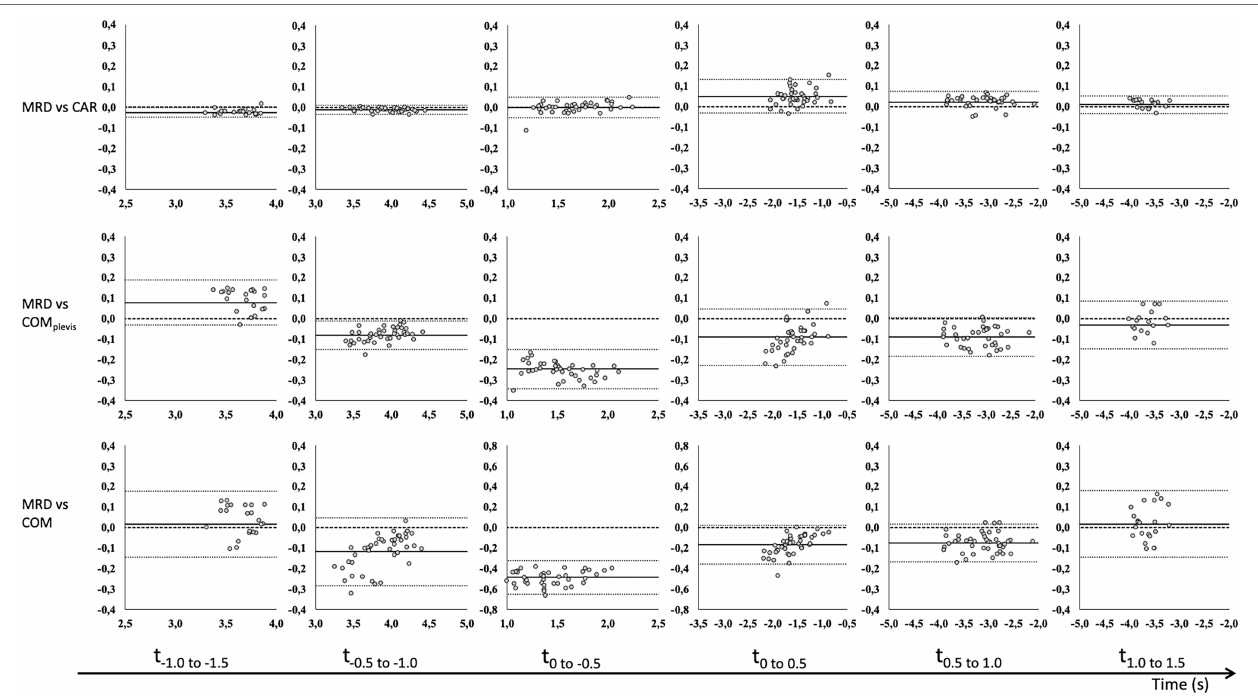
FIGURE 4 | Bland–Altman analysis of average velocity for 0.5 s time intervals before ( − ) and after (+) CoD (horizontal axis) for the MRD to CAR (top row), COM pelvis (middle row) and COM (bottom row) for 9 kg external load. Bland–Altman plots [y-axis: difference in velocity (m/s) and x-axis: average velocity (m/s)] for all trials with fixed bias (full line) with 95% confidence interval (dotted line) and agreement (dashed